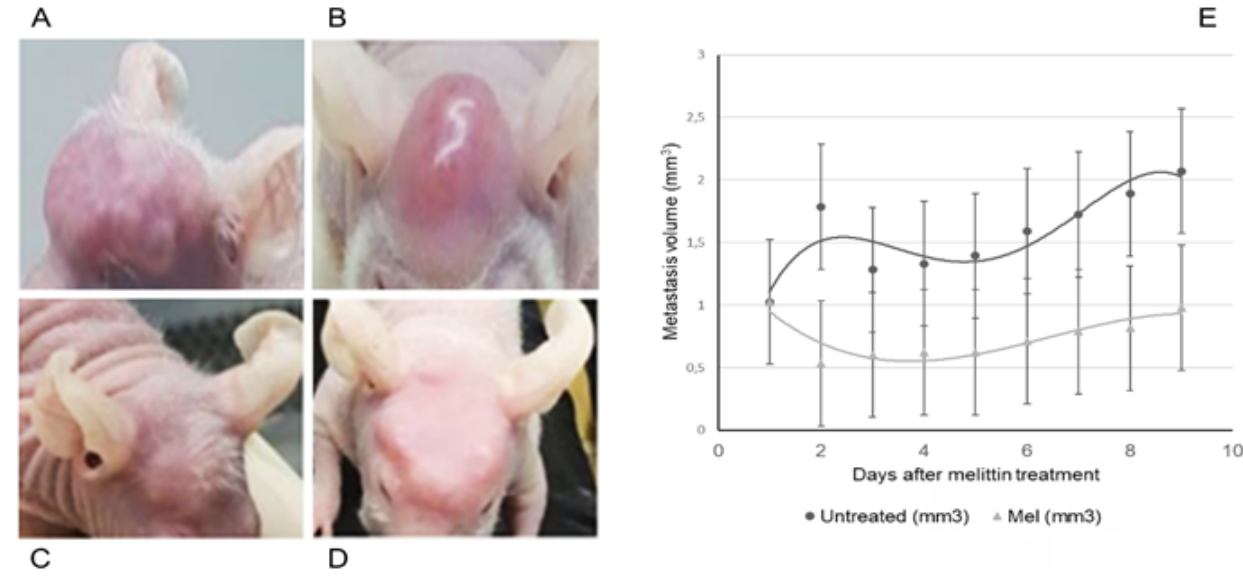
Figure 3. In vivo efficacy of melittin. CRC bone metastasis (A, B) one day before melittin intrametastatic injection and (C, D) seven days after a single dose of melittin (day 27). (E) Metastasis normalized volume (mean ± SD) evolution in untreated (n = 3) or melittin-treated animals (n = 6) (p < 0.001). (C, D) After intrametastatic melittin injection, bone metastases are smaller than in (A, B) untreated animals. Seven days after melittin injection, metastases started growing